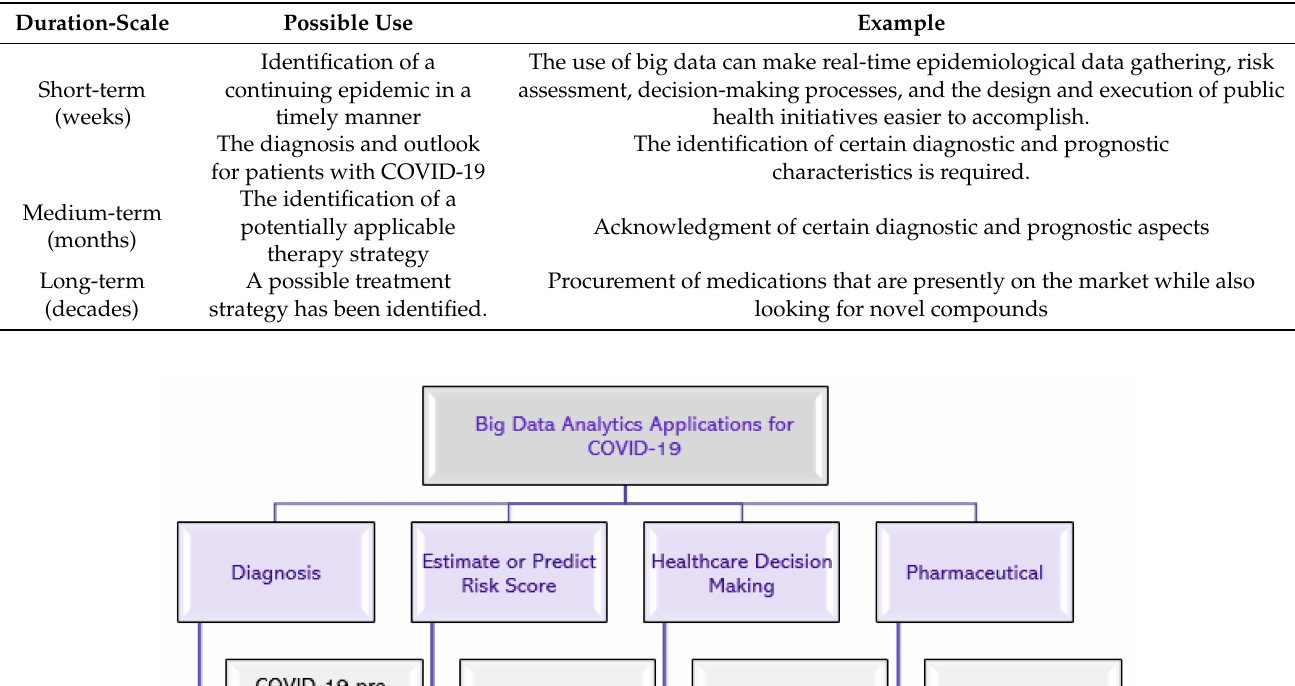
Table 2. Possible uses of big data for the management of an ongoing COVID-19 outbreak, data accessed from [3].